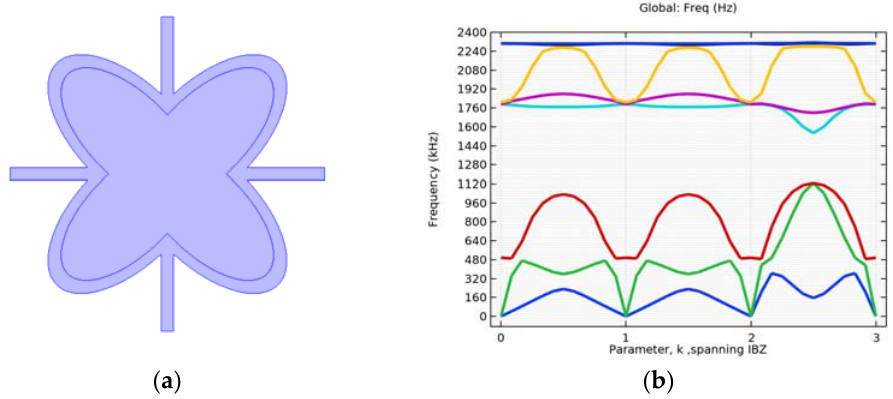
Figure 12. Response for inner ellipse 170 × 80, rod 12 mm. ( a ) microstructure, ( b ) responce for first eigenfrequenciew. One band gap exists, between 3rd and 4th eigenfrequency (1050–1530 Hz).